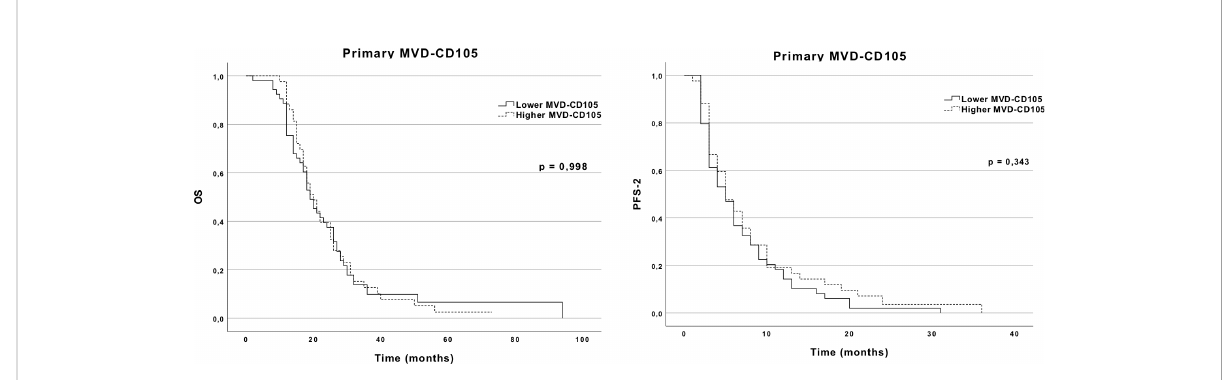
FIGURE 3 OS and PFS-2 Kaplan – Meier curves according to MVD-CD105 expression in the primary